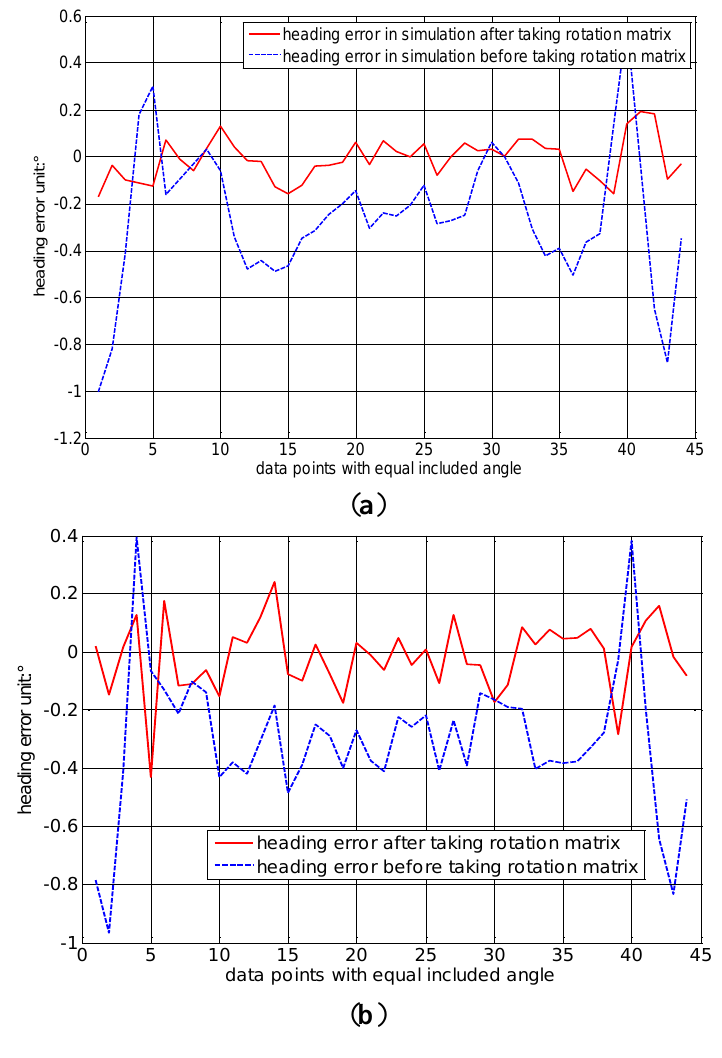
Figure 5 . ( a ) Heading error when the standard deviation of the noise is 0.002; ( b ) Heading error when the standard deviation of the noise is 0.003; and ( c ) Heading error when the standard deviation of the noise is